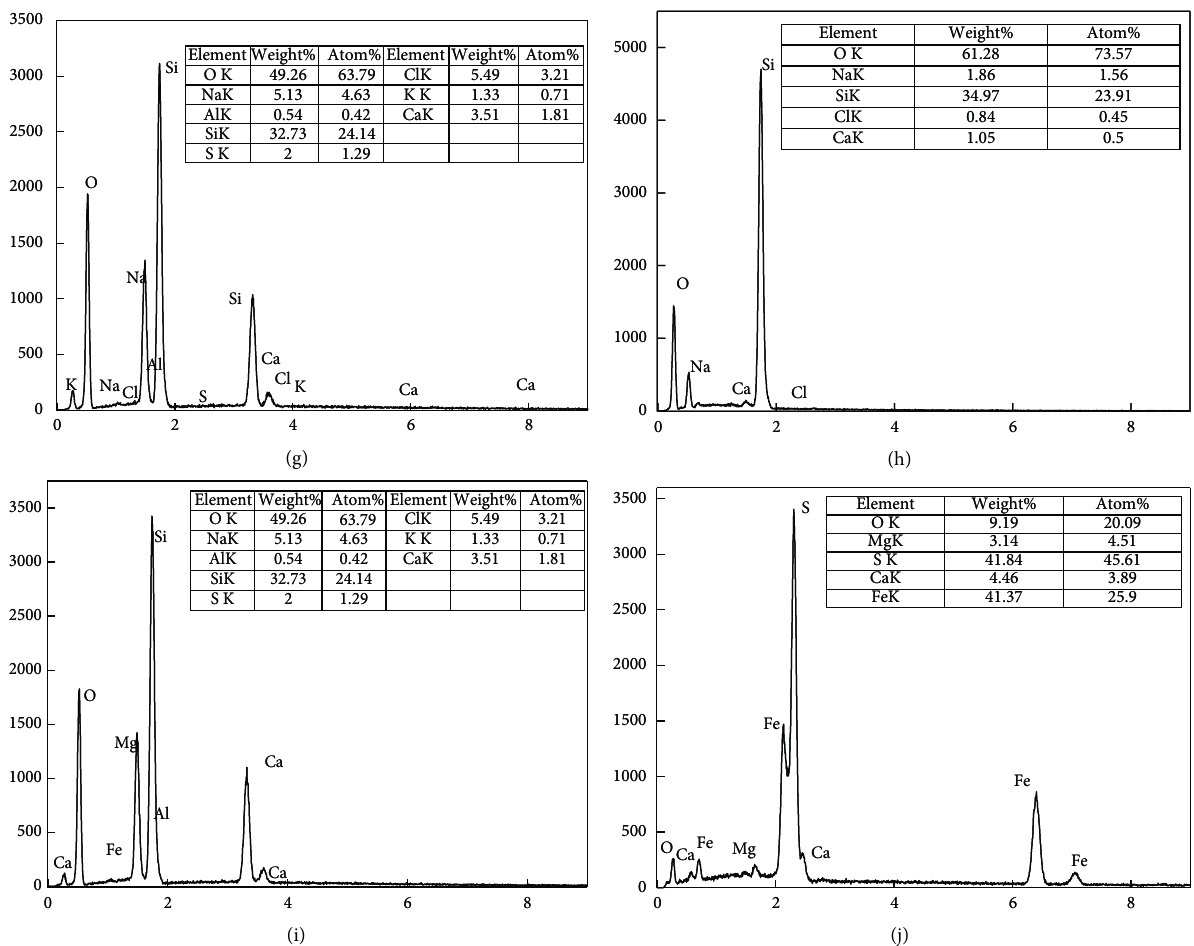
Figure 1: Photomicrograph and energy spectrum of the fly ash and its single